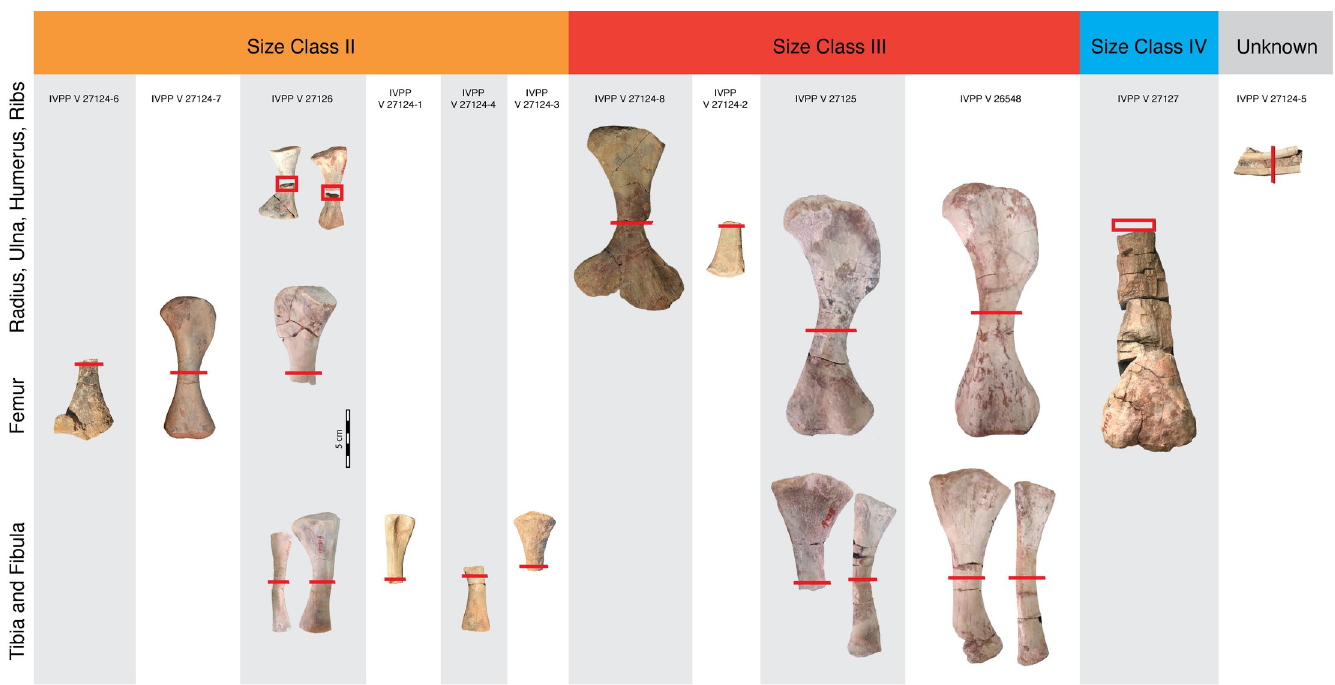
Fig 1. Size distribution of Lystrosaurus sp. postcrania from the Jiucaiyuan Formation included in the histologic analysis. Twenty skeletal elements, with gray bars indicating associations of individuals, span three size classes inferred from femoral length: Size Class II spans 47–63% maximum femoral size, Size Class III includes specimens that are ~ 70% maximum size, and Size Class IV includes the largest partial femur. Scale bar = 5 cm.